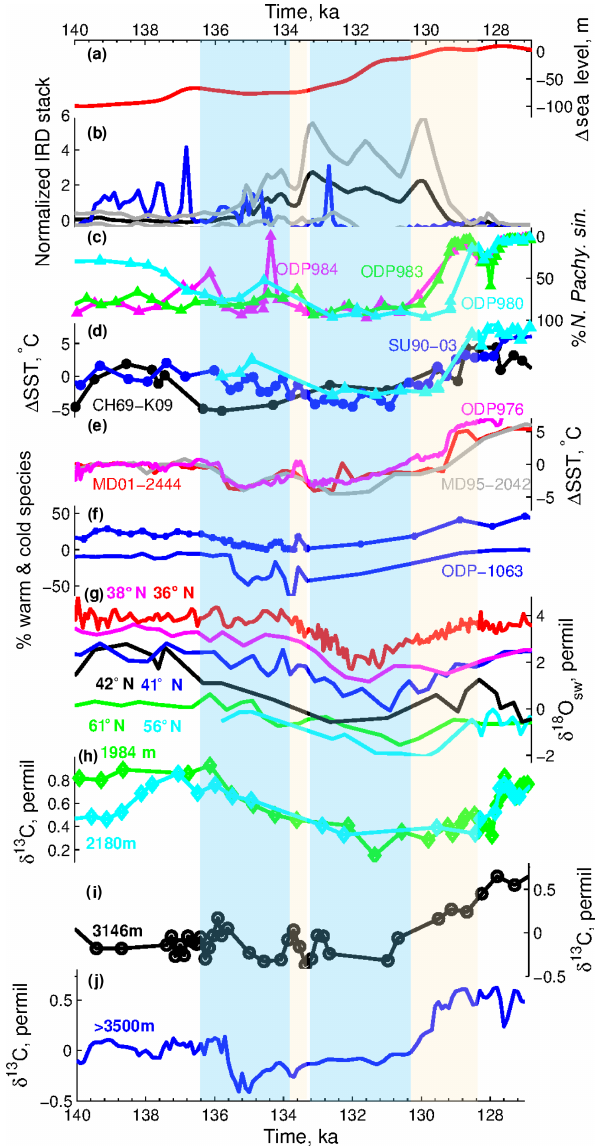
Figure 8. Selection of RSL and North Atlantic marine sediment records: (a) Red Sea RSL record (Grant et al., 2012), with revised age scale as described in Sect. 5. (b) Normalized IRD stack (black) of cores CH69-K09 (Labeyrie et al., 1999), ODP980 (Oppo et al., 2006), ODP983 (Barker et al., 2015), ODP984 (Mokeddem et al., 2014), ODP1063 (Deaney et al., 2017) and SU90-03 (Chapman and Shackleton, 1998) with ± 1 σ (grey envelope). Normalized IRD record of MD95-2010 (blue) (Risebrobakken et al., 2006). (c) Neogloboquadrina pachyderma sin. (%) in cores ODP980 (cyan) (Oppo et al., 2006), ODP983 (green) (Barker et al., 2015) and ODP984 (magenta) (Mokeddem and McManus, 2016). (d) Estimated summer SST anomalies ( ◦ C) in cores ODP980 (cyan), CH69-K09 (black) (Labeyrie et al., 1999) and SU90-03 (blue) (cid:48) (Chapman and Shackleton, 1998). (e) U k SST anomalies ( ◦ C) in cores MD01-2444 (red) (Martrat et al., 2007), ODP976 (magenta) and 37 MD95-2042 (grey) (Martrat et al., 2014); (f) percentage of warm (circles) and cold (axis reversed) species in core ODP1063 (Deaney et al., 2017). (g) Estimated δ 18 O sw (‰) in cores ODP976 (red), MD95-2042 (magenta) (Martrat et al., 2014), SU90-03 (blue) (Chapman and Shackleton, 1998), CH69-K09 (black) (Labeyrie et al., 1999), ODP984 (green) (Mokeddem and McManus, 2016) and ODP980 (cyan) (Oppo et al., 2006); Benthic δ 13 C (‰) in cores (h) ODP983 (green) (Lisiecki and Raymo, 2005) and ODP980 (cyan) (Oppo et al., 2006). (i) MD95-2042 (black) (Martrat et al., 2014). (j) a δ 13 C stack of cores U1308, CH69-K09 and ODP1063 (Labeyrie et al., 1999; Hodell et al., 2008; Deaney et al., 2017). All the age models have been revised as described in the Methods section and in Govin et al.